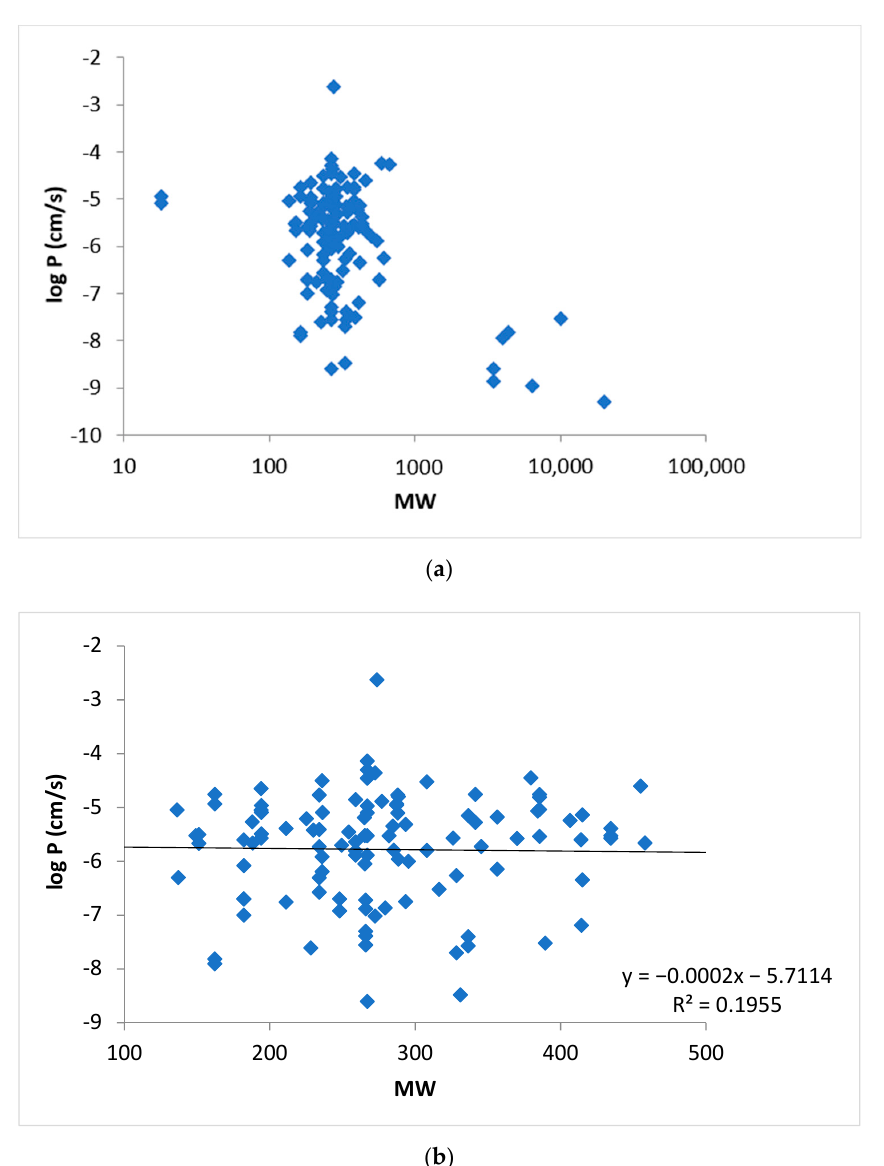
Figure 4. ( a ) Relationship between log P and MW for all applicable permeants in Table A1. ( b ) En- larged figure to evaluate the relationship between log P and MW of permeants in the 130–460 Dalton range. Table 2. Regression analysis results of log P with log D ow and MW as independent variables (first three rows) and log ( P/D ow ) with log K ow and MW as independent variables (last three rows), using the data of all permeants and then perme- ants with log D ow > − 1 and > 0. The parameters are defined in Equations (6) and (10). The values presented are the least squares means and standard errors of the parameters.